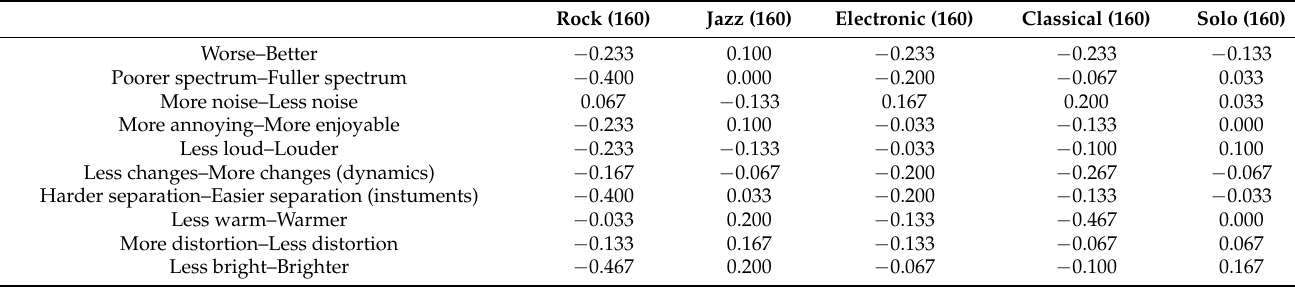
Table A4. Average evaluation scores for the bipolar scales for 160